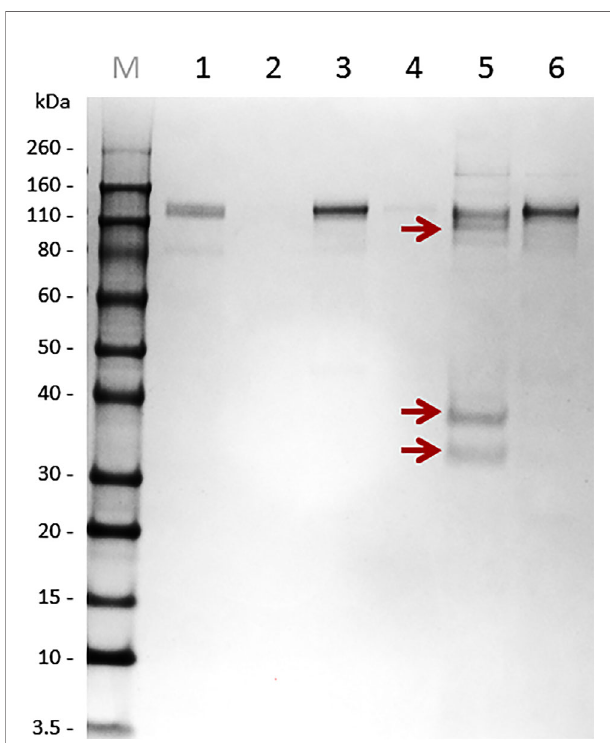
FIGURE 2 | Non-reducing SDS-PAGE separation of immunoprecipitated salivary antigens using protein A paramagnetic beads. Immunoglobulins (Ig ’ s) from both immunized (repeated feeding) and naïve rabbit sera were immobilized on Protein A magnetic beads. These immunoglobulin-loaded beads were used for antigen fi shing in pilocarpine-induced saliva of I. ricinus females fed on a rabbit for six days. Bound antigens to immunoglobulins from immunized and naïve rabbits were eluted and subjected to SDS-PAGE. M – Novex Sharp Marker, 1 – immunoglobulin fraction from “ immunised ” rabbits, 2 – SN after bead pelleting (indicates immobilization of “ immunised ” Ig ’ s on Protein A beads), 3 – immunoglobulin fraction from naïve rabbits, 4 – SN after bead pelleting (indicates immobilization of naive Ig ’ s on Protein A beads), 5 – elution fraction from “ immune ” beads, 6 – elution fraction from “ naïve ” beads. Bands from experimental group (red arrows) and corresponding areas from the control gel control were sliced out the gel and subjected to proteomic